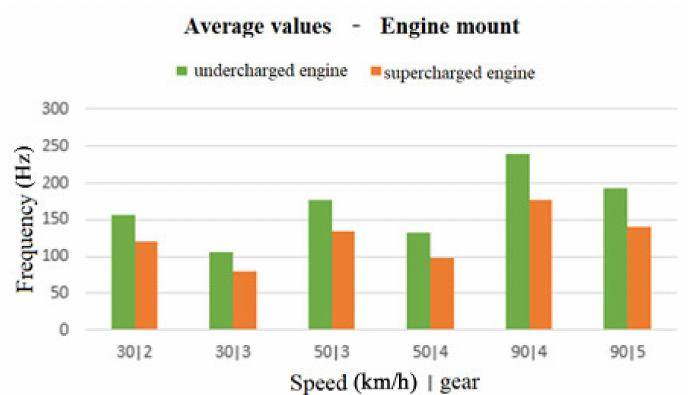
Figure 5. Comparison of averaged values of dominant vibration harmonics measured on the engine for older (green) and newer